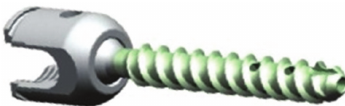
Figure 1: The titanium Expedium fenestrated screw (VIPER MIS Spine System, DePuy Spine, Johnson & Johnson) is a polyaxial, fully cannulated with six fenestrations in the grooves of the distal portion of the thread and an opening at the distal